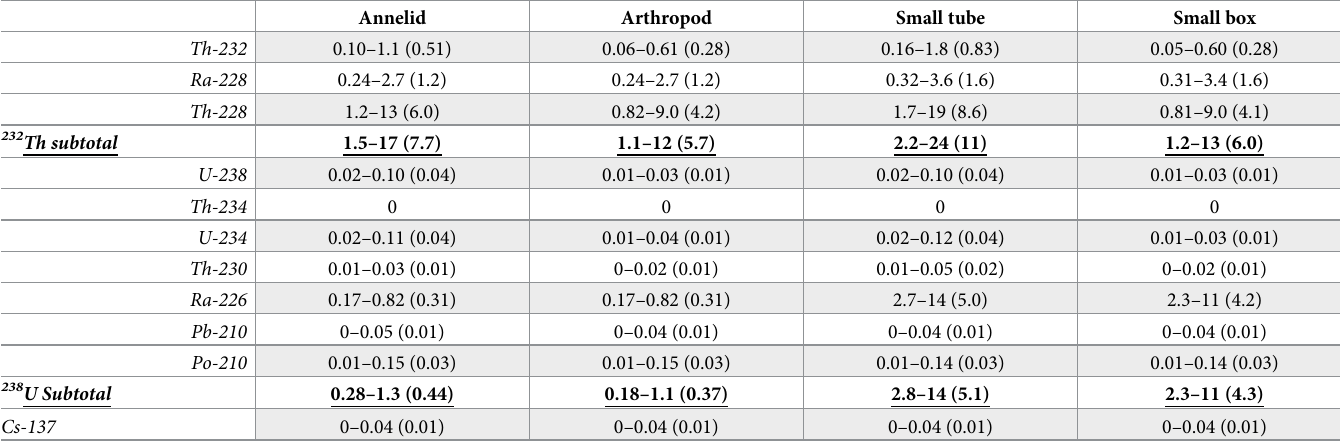
Table 3. Radionuclide dose rates.